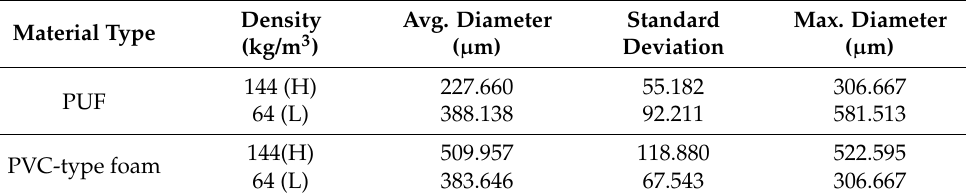
Table 2. Cell diameter sizes of neat PUFs and PVC-type foams.